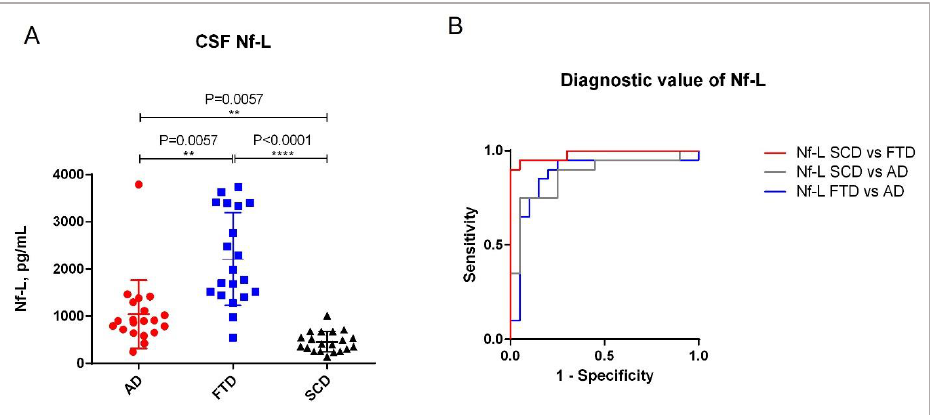
Figure 7. Clinical validation of the Nf-L ELISA. ( A ) CSF Nf-L concentrations in different diagnostic groups. The analysis was carried out using a Kruskal–Wallis analysis of variance (ANOVA) for multiple comparisons. ( B ) ROC curves. The graph shows the diagnostic value of CSF Nf-L in the clinical diagnostic groups AD and FTD, as well as in SCD. (On Graphpad Prism, **: p ≤ 0.01; ****: p ≤ 0.0001)